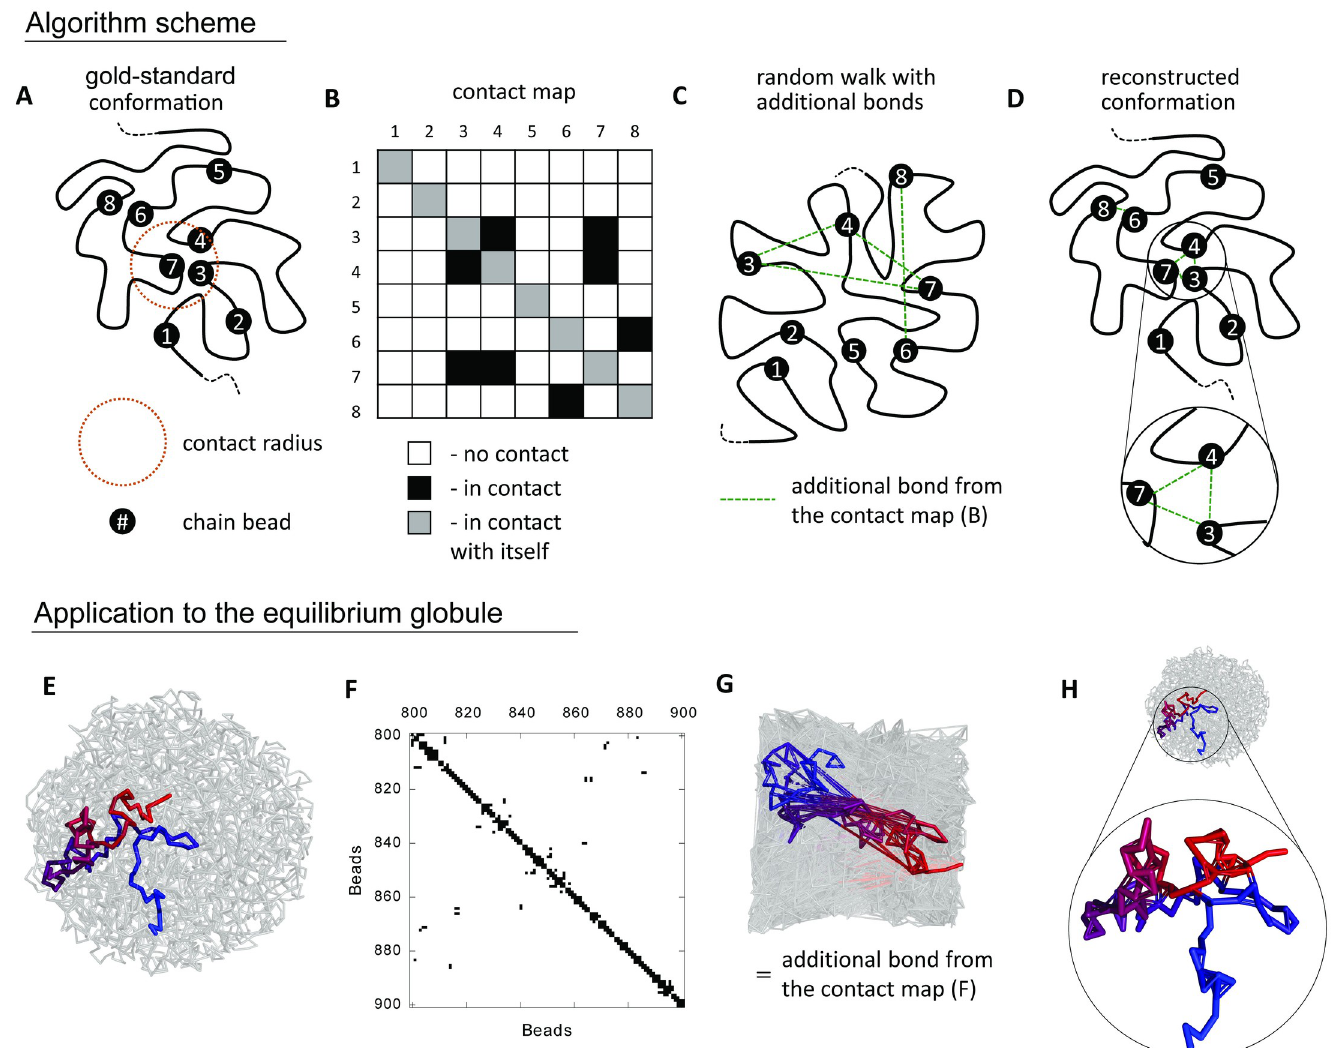
Fig 1. The algorithm scheme (A-D) and a demonstration of its application to the equilibrium globule (E-H). A . The worm-like view of a chain fragment. The numbers denote beads selected for the demonstration. B . The contact map corresponds to the gold-standard conformation (A). C . The chain in a random walk conformation with additional bonds from the contact map (B). D . The chain after equilibration (C), a.i . the reconstructed conformation. E . The equilibrium globule with l 0 = 0.5, semitransparent gray. The chain segment 800–900 is highlighted and colored from red to blue. F . The contact map for the highlighted segment from (E), = 0.8. G . The initial conformation of the chain generated as a random walk in a cubic cell. Additional bonds from the contact map are the contact radius is set to r contact added to the system, most of them are overstretched before equilibration. The same chain region as in (E) is highlighted. H . The equilibrated system of (G). The magnifying pan shows the highlighted region from (E) with additional